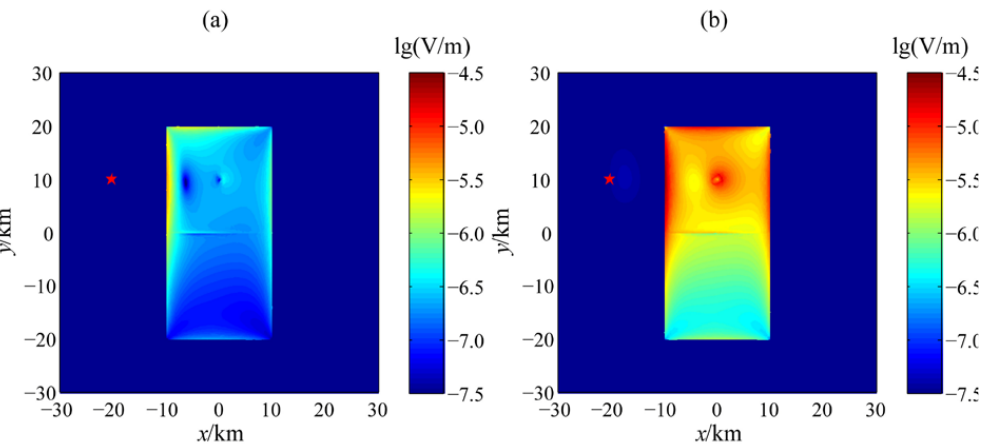
Fig. 4. Electric field distribution on the surface (modified after Huang and Lin, 2010b). (a) Results of the model given to Fig. 3. (b) Results of the model after adding in Fig. 3 a horizontal conductive channel at a depth of 10km, connecting the dipole current source and the vertical underground conductive channel.